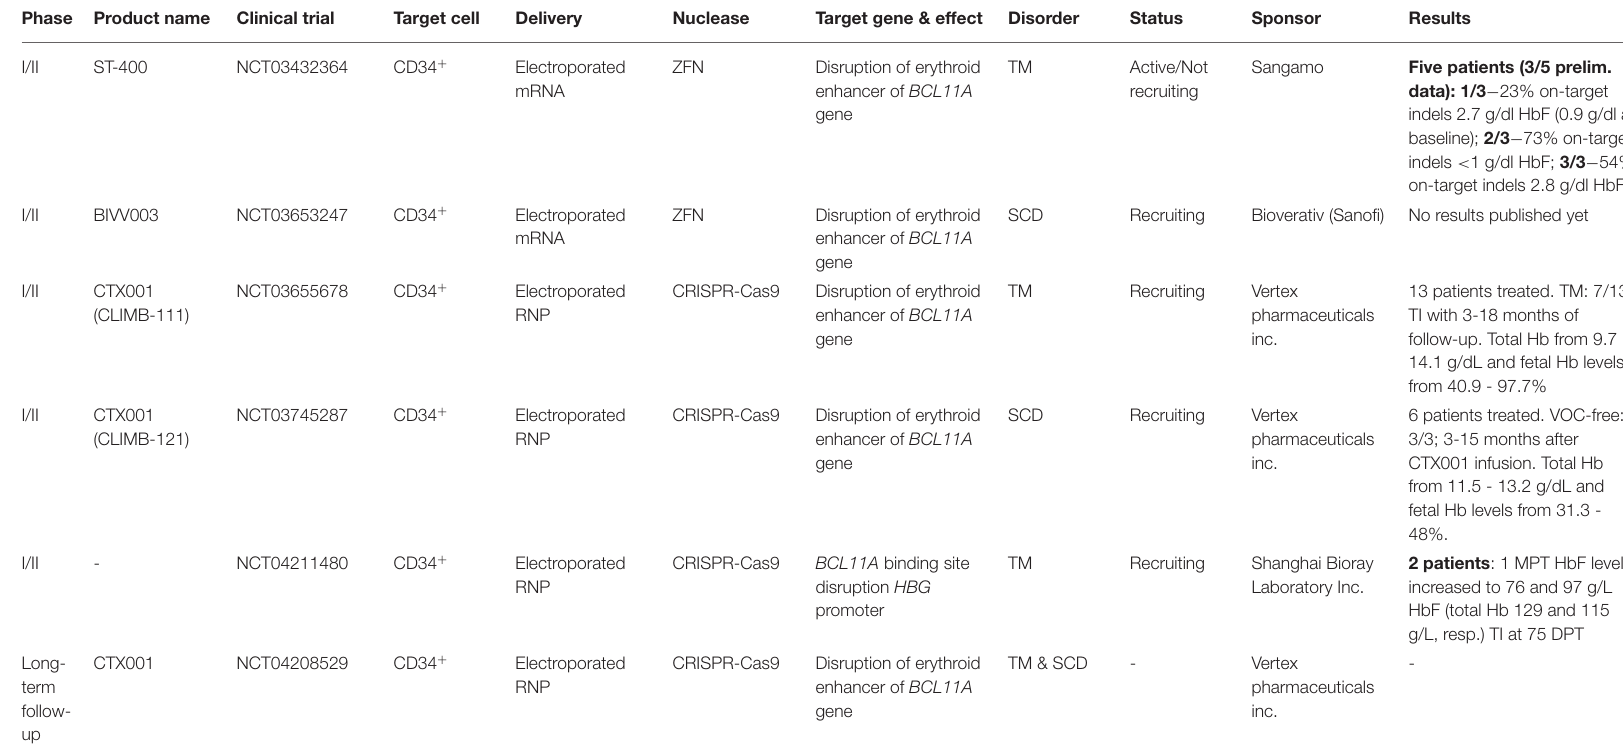
TABLE 2 | Genetic therapies in development based on gene